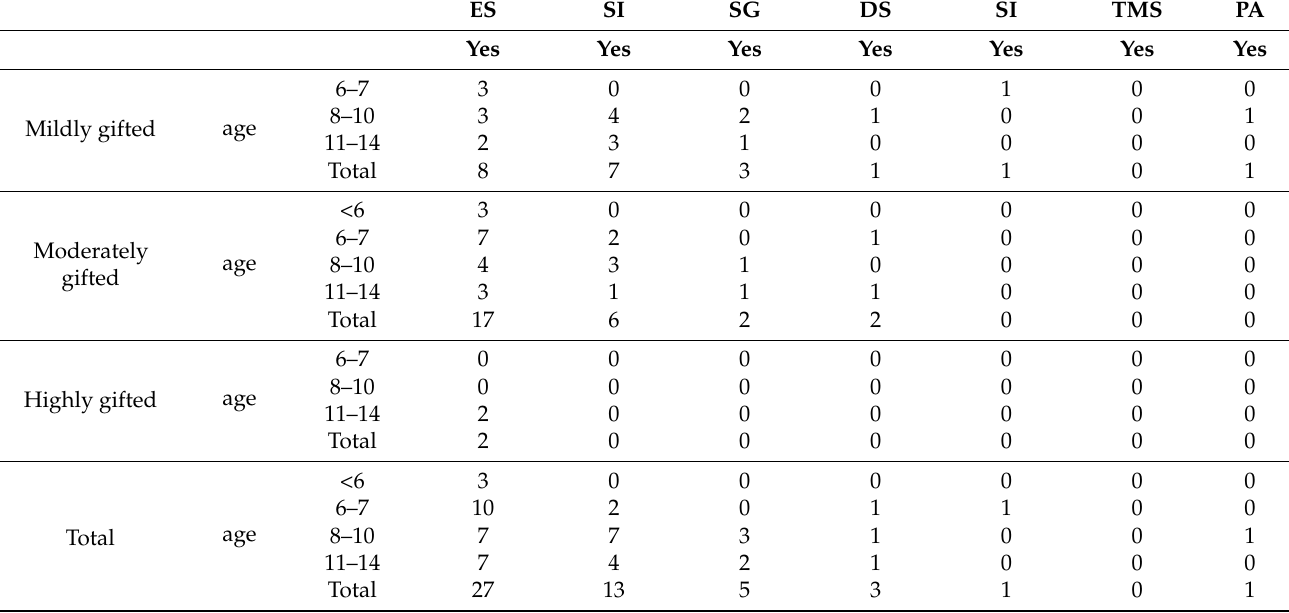
Table 8. Parenting